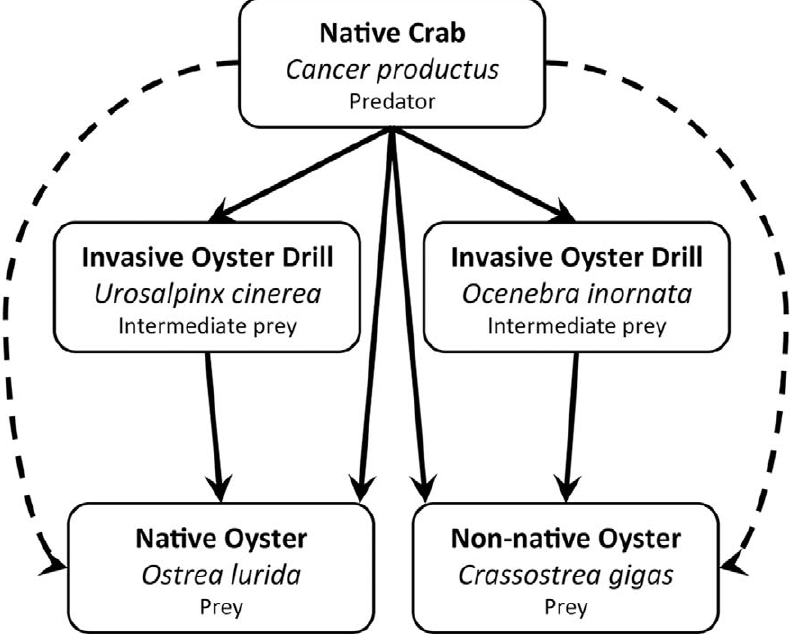
Figure 1. Diagram of trophic interactions in our study system. Diagram of trophic interactions among native red rock crabs, Cancer productus , two species of invasive oyster drill, Urosalpinx cinerea and Ocenebra inornata , and two oyster species, native Ostrea lurida and non-native Crassostrea gigas . Solid lines represent direct interactions, dashed lines indirect interactions with all arrows pointing in the direction of the trophic effect.